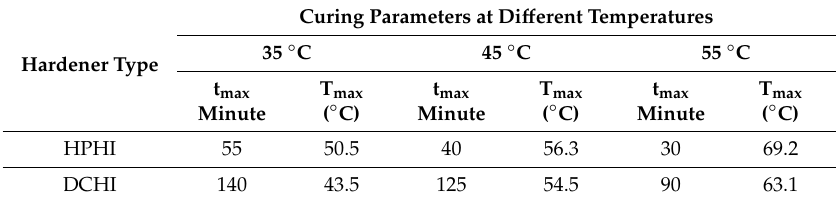
Figure 8. Curing exothermic of ( a ) bisphenol A diglycidyl ether (DGEB) / HPHI (1.76:1 wt.%) and ( b ) DGEB / DCHI (1.42:1) at di ff erent temperatures. Table 2. Curing parameters of bisphenol A diglycidyl ether (DGEB) with HPHI or CDHI at di ff erent